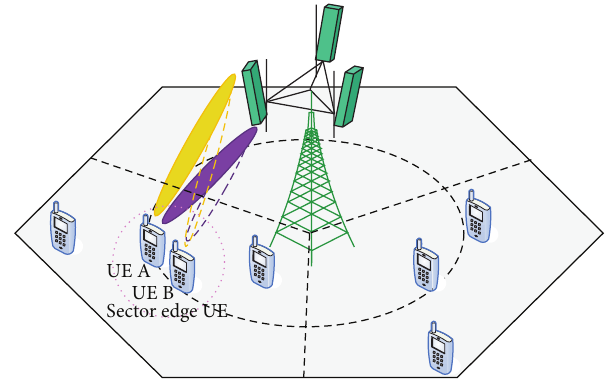
Figure 5: Proposed resource allocation